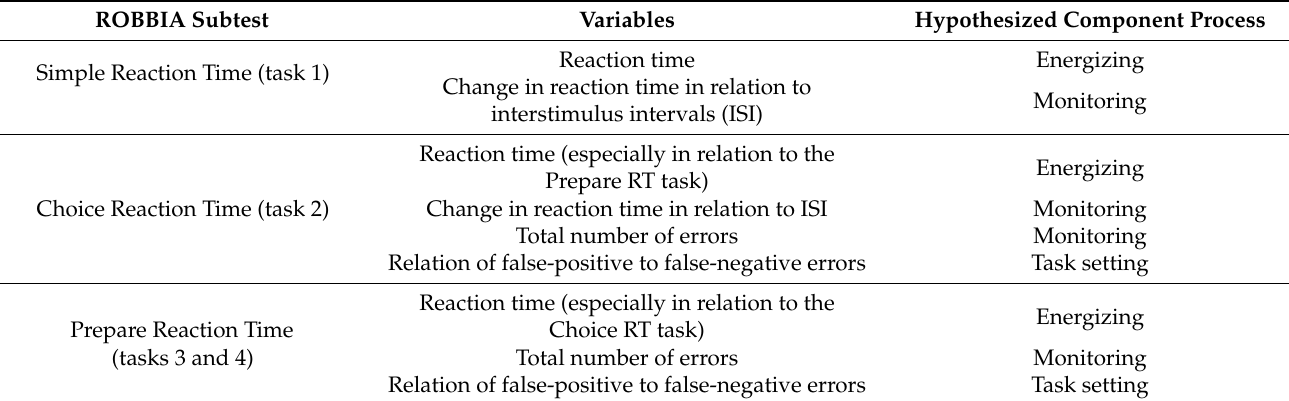
Table 1. ROBBIA subtests and tested components